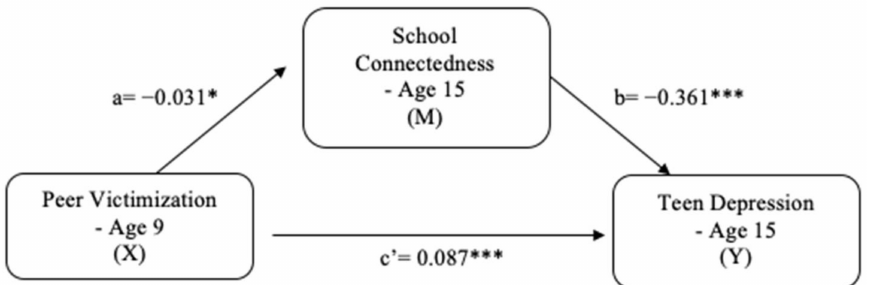
Figure 2. Mediation model for teen depression. * p < 0.05; *** p < 0.001. Note: The path coefficients (a, b, c’) estimate the strength of the hypothesized associations using unstandardized regression coefficients; a = the direct effect of X on M; b = the direct effect of M on Y; c’ = the direct effect of X on Y.